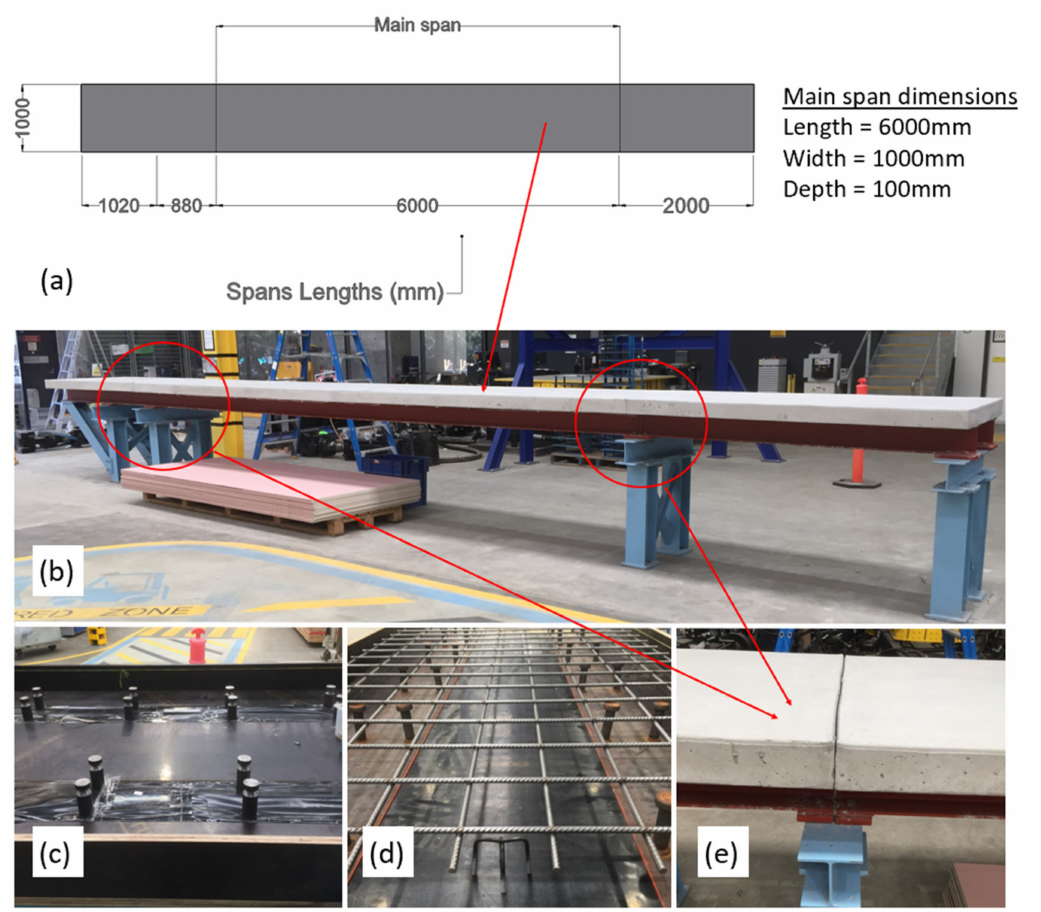
Figure 6. ( a ) plan view and dimensions, ( b ) the bridge after construction, ( c ) covers embedded in the concrete slab in main span for the removable shear connectors, ( d ) reinforced bars alignments and ( e ) discontinuous slabs